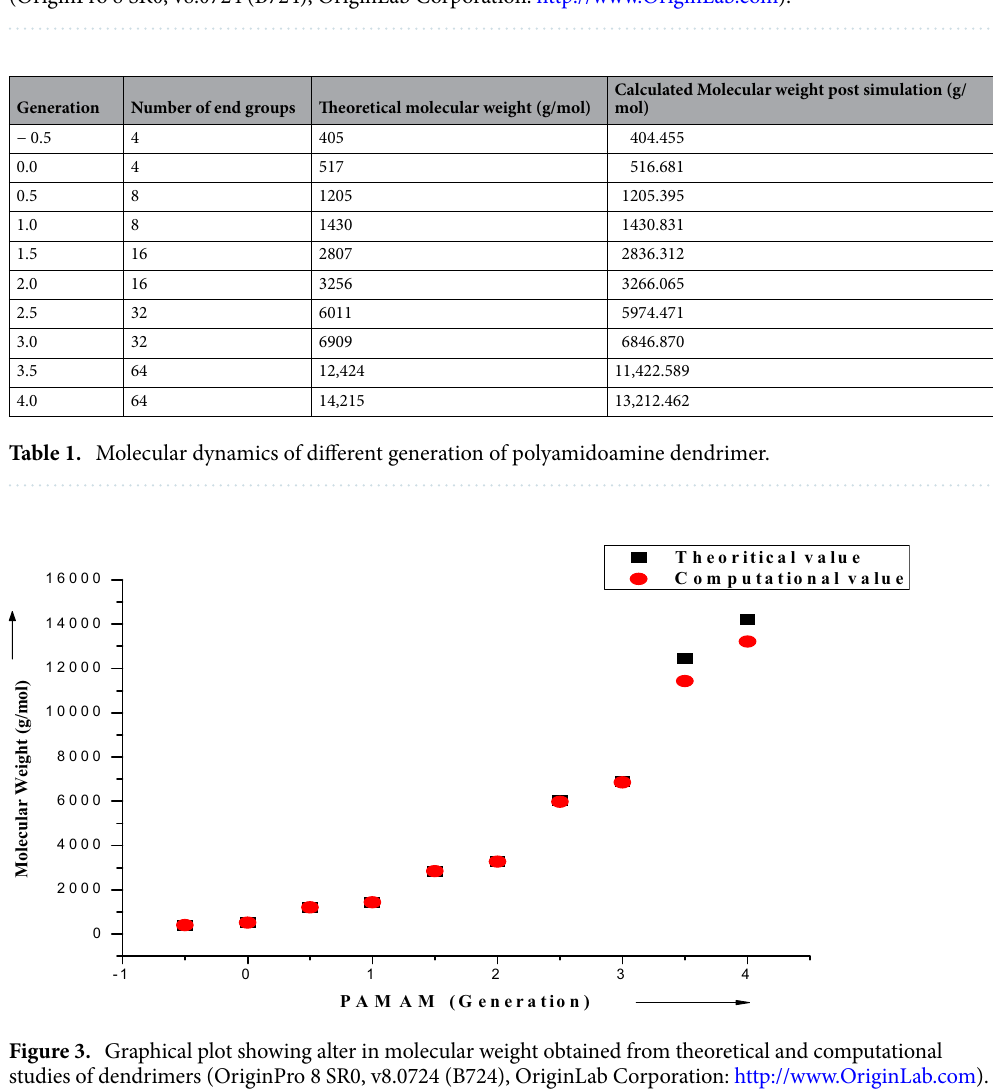
Figure 2. Polyamidoamine generation dependence of the average radius between central atom of dendrimer (OriginPro 8 SR0, v8.0724 (B724), OriginLab Corporation: http://www.Origi nLab.com).